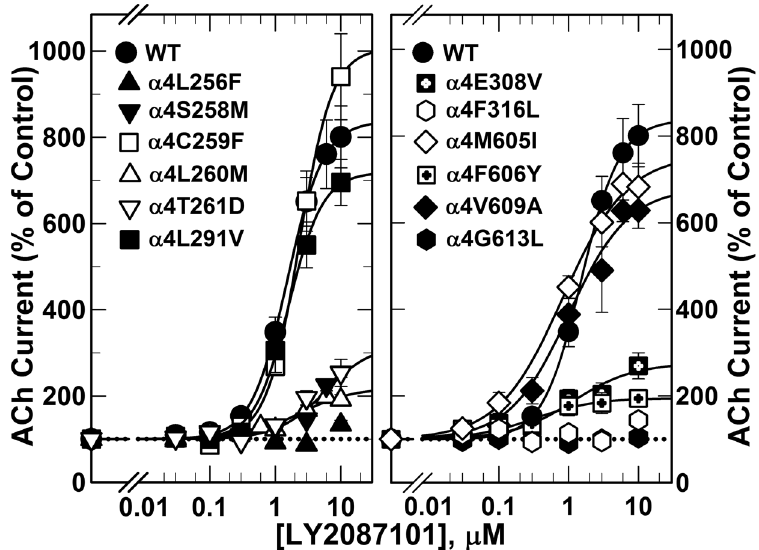
Figure 6. LY2087101 concentration-dependent potentiation of WT and mutant α 4 β 2 nAChRs. Peak ACh- induced current responses of Xenopus oocytes expressing WT or mutant ( α 4)3( β 2)2 nAChRs in the presence of increasing concentrations of LY2087101 were normalized to the peak current elicited by 10 µ M ACh alone. Shown are data (Average ± SE) from several oocytes. Data were fit to a single site model using Equation 1 and parameters (potentiation EC 50 and I max ) are shown in Table